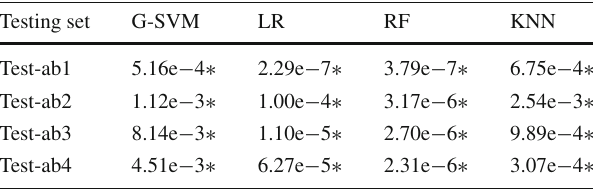
Table 13 p values of Acc between the four traditional classifiers and our DI-Transformer using FT-IMF all features Testing